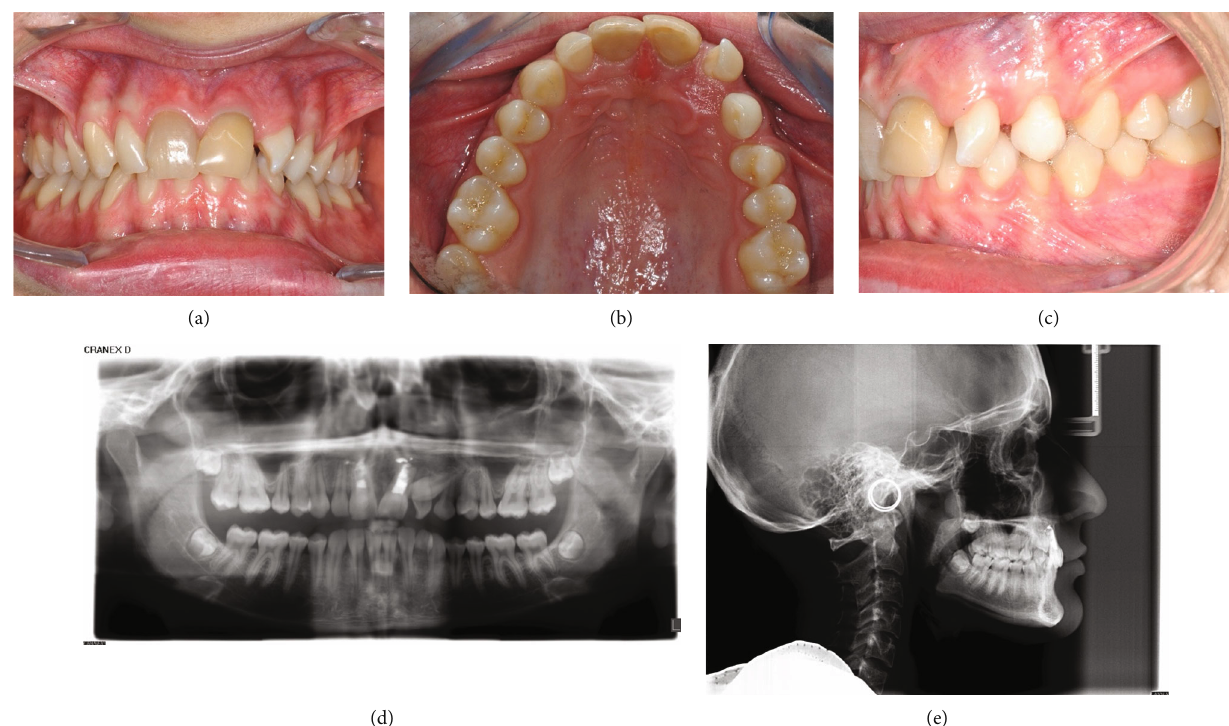
Figure 1: (a – c) Pretreatment intraoral and (d and e) radiographical